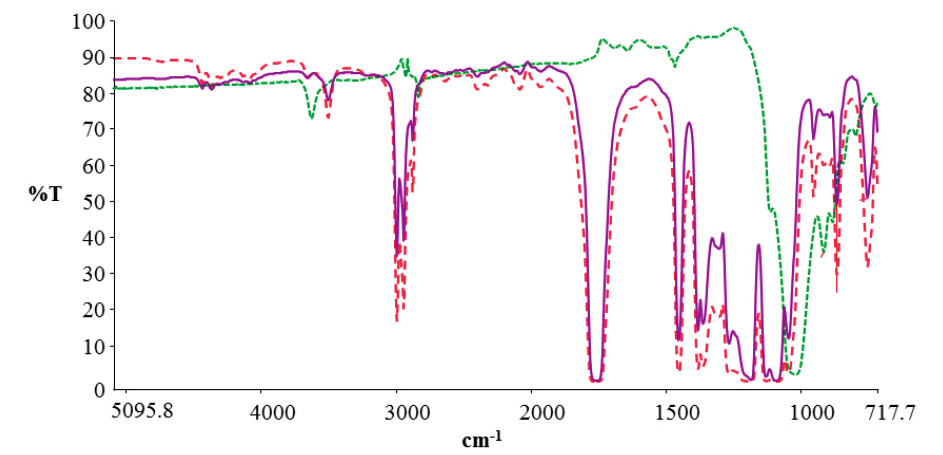
Figure 4. FTIR of PLA–AM in red , PLA–AM CB (10 pph) in purple and pure Cloisite 30B in Green